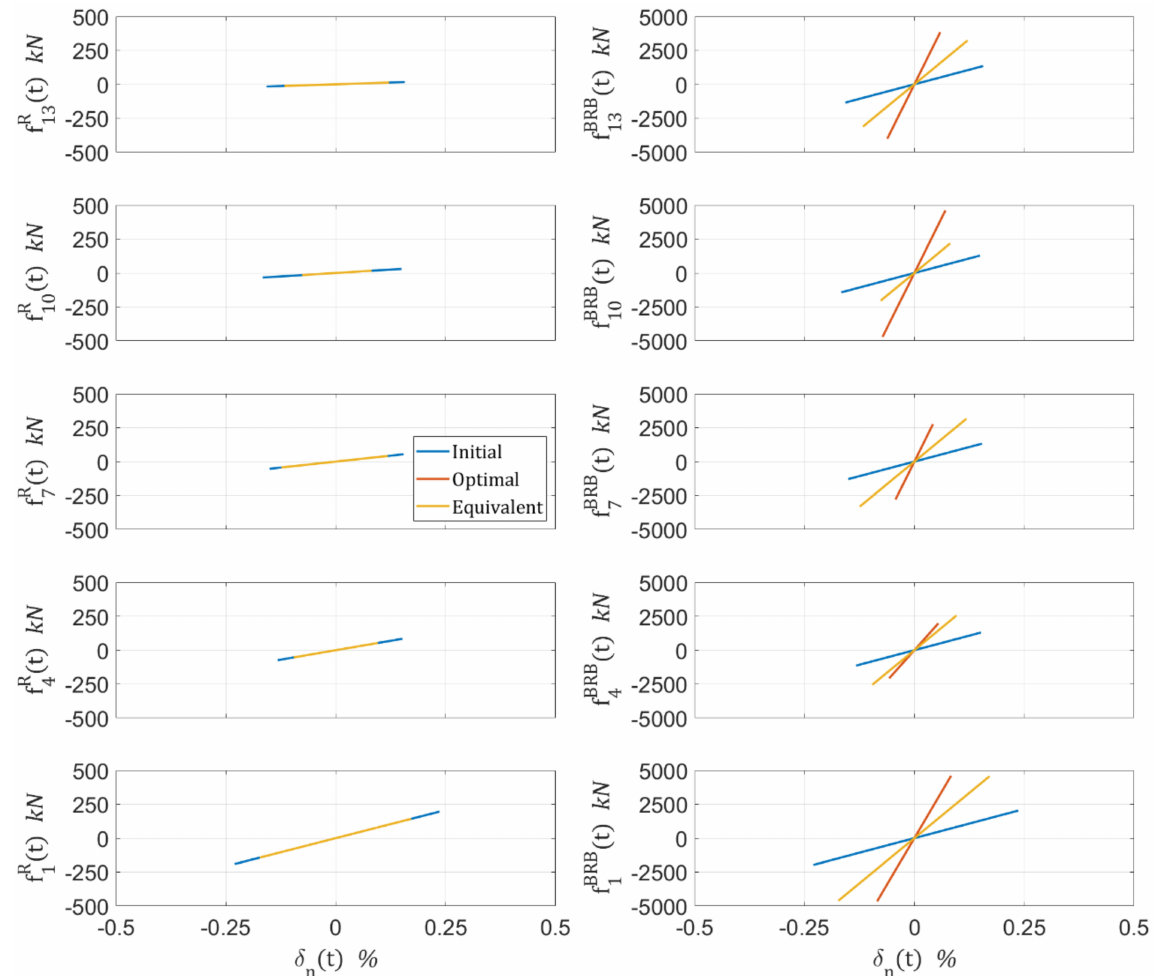
Figure 16. Hysteretic resisting forces of the 15-story frame system under the Valparaiso 2017 earth-